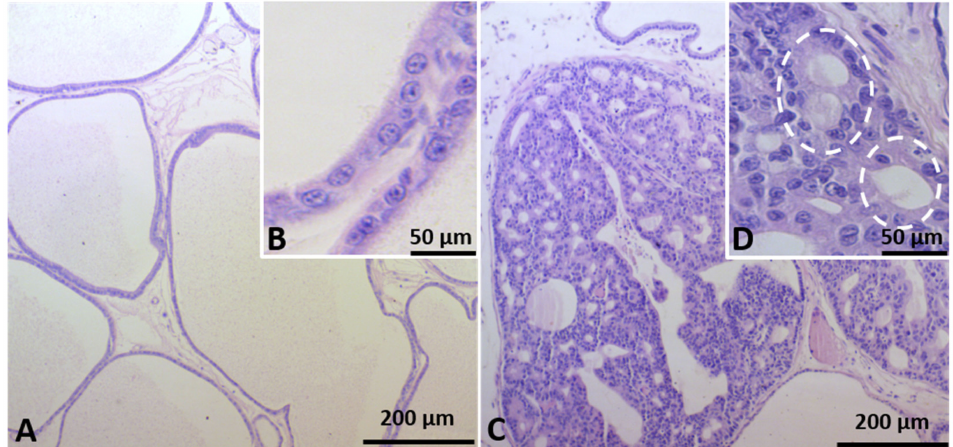
Figure 1. Representative histological sections of the VP lobes from the CTR ( A , B ) and GLLP ( C , D ) groups at PND 540 stained with hematoxylin/eosin (HE). In the CTR group, the VP histology resembles the structural characteristic of older VP with normal glandular and stromal compartments. In the GLLP group, the glandular lumen was filled with a dysplastic cell mass with microacinar structures (dashed circle). Scale bar: 200 µ m ( A , C ) and 50 µ m ( B , D ). CTR: Control; GLLP: Gestational and Lactation Low